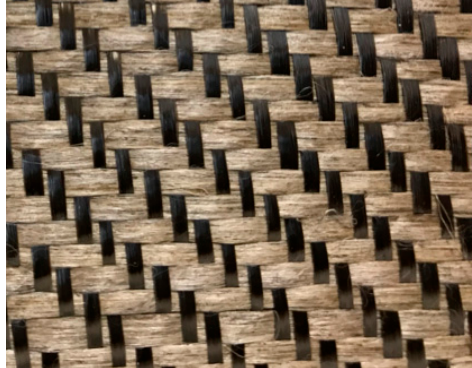
Figure 1. Close-up view of the dry flax/basalt hybrid fabric (dark yarn = basalt; bright yarn = flax).